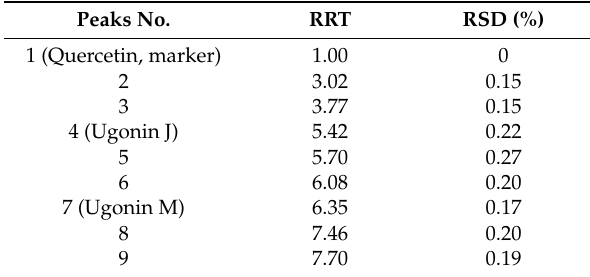
Table 2. The RRTs a and RSDs of the nine characteristic peaks. Peaks No.